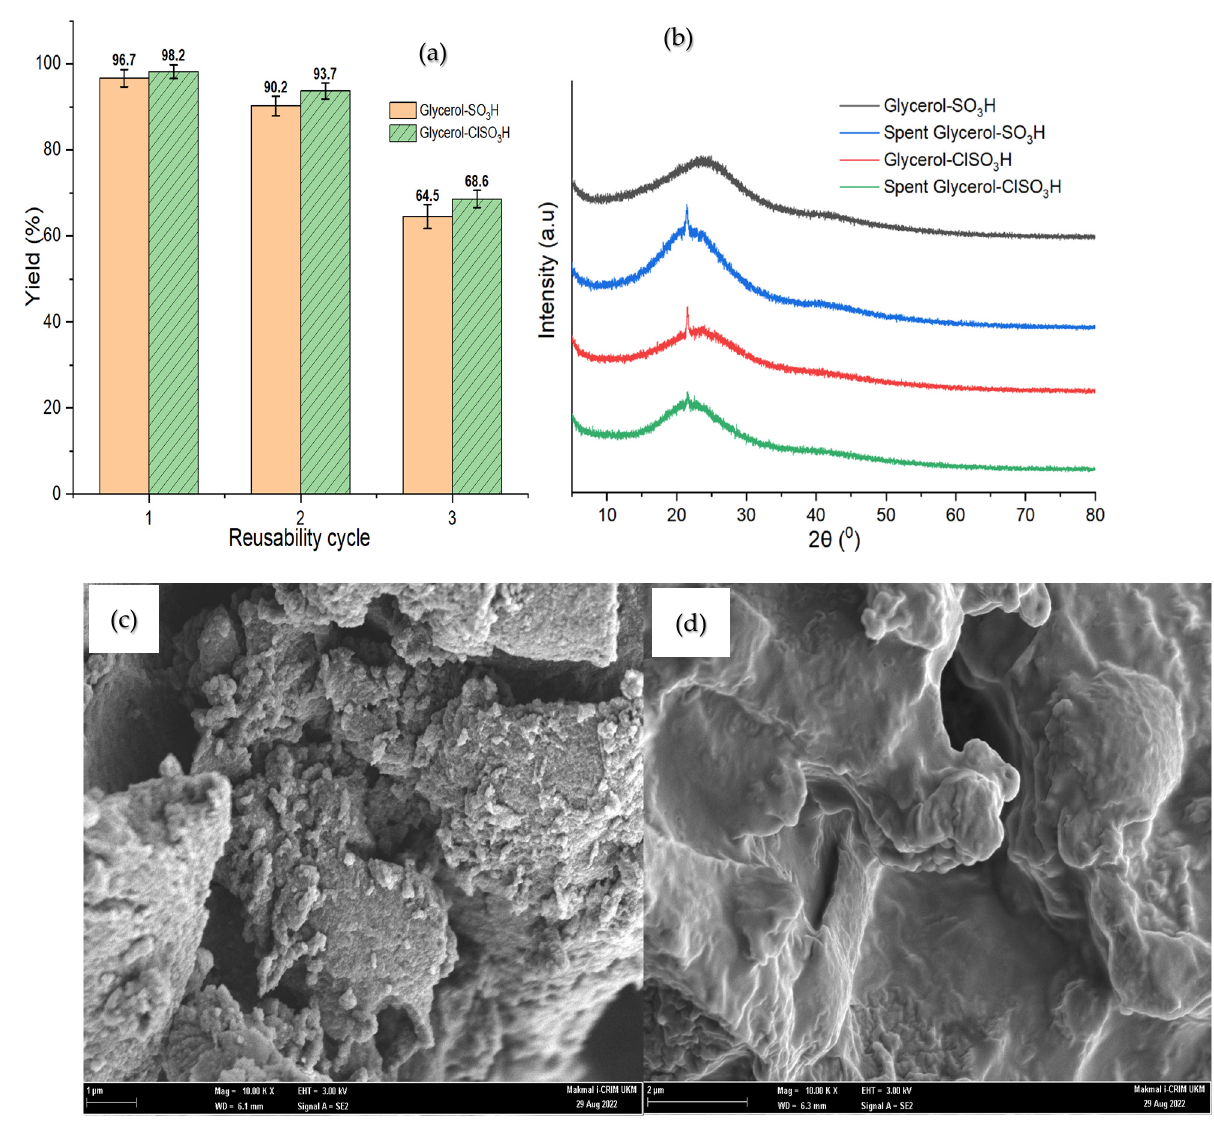
Figure 9. ( a ) Esterification reusability cycles graph, ( b ) XRD, ( c ) spent Glycerol-SO 3 H, ( d ) spent Glycerol-ClSO 3 H.